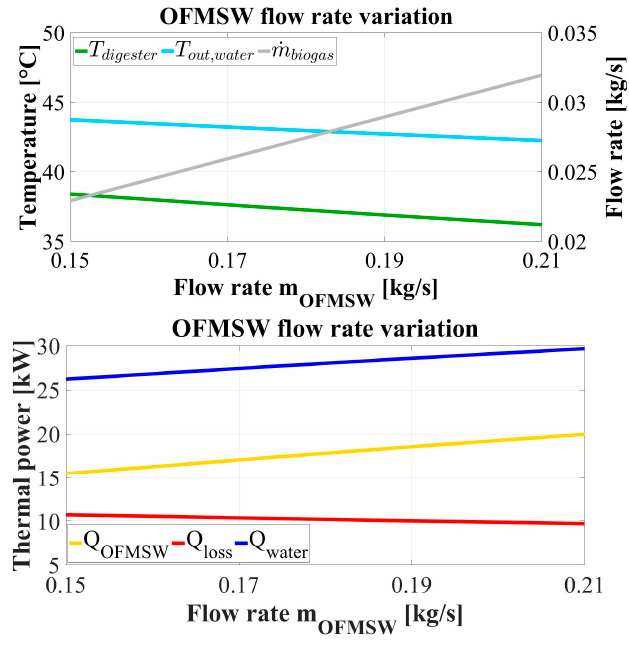
. . . Q & , Q & , Q & (below) vs Q OFMSW , Q loss , Q water (below) vs. OFMSW loss water